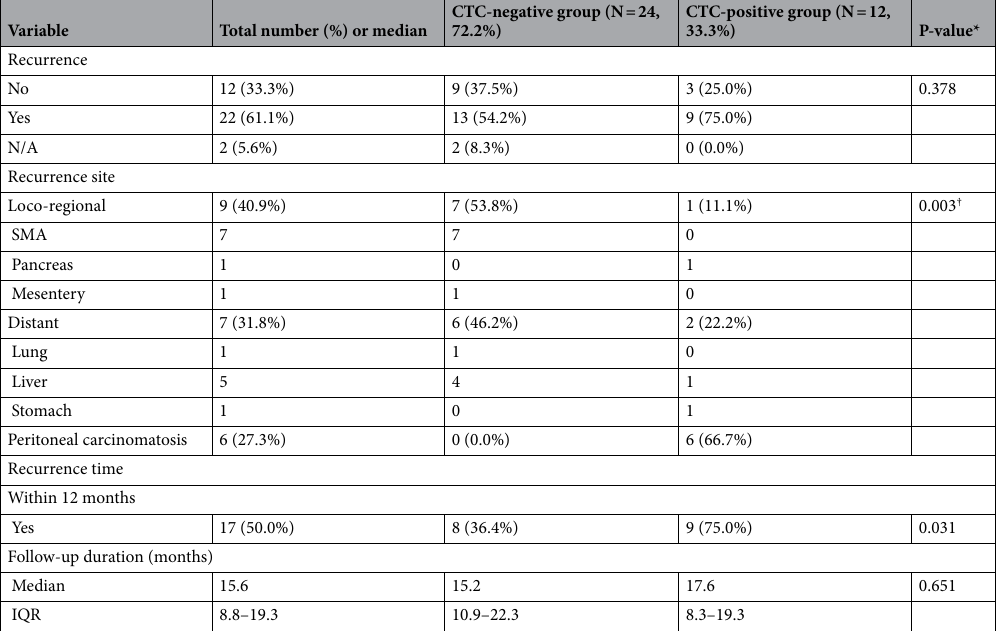
Table 3. Subanalysis of the recurrence patterns according to the detection of circulating tumour cells. CTCs circulating tumour cells, SMA Superior mesenteric artery, IQR interquartile range. *The p-values were calculated using the Student t -test or Mann–Whitney U test for continuous variables and the χ 2 test or Fisher exact test for binary variables between the CTC-negative and CTC-positive groups. † Systemic recurrence (distant metastasis and peritoneal carcinomatosis) vs. Loco-regional